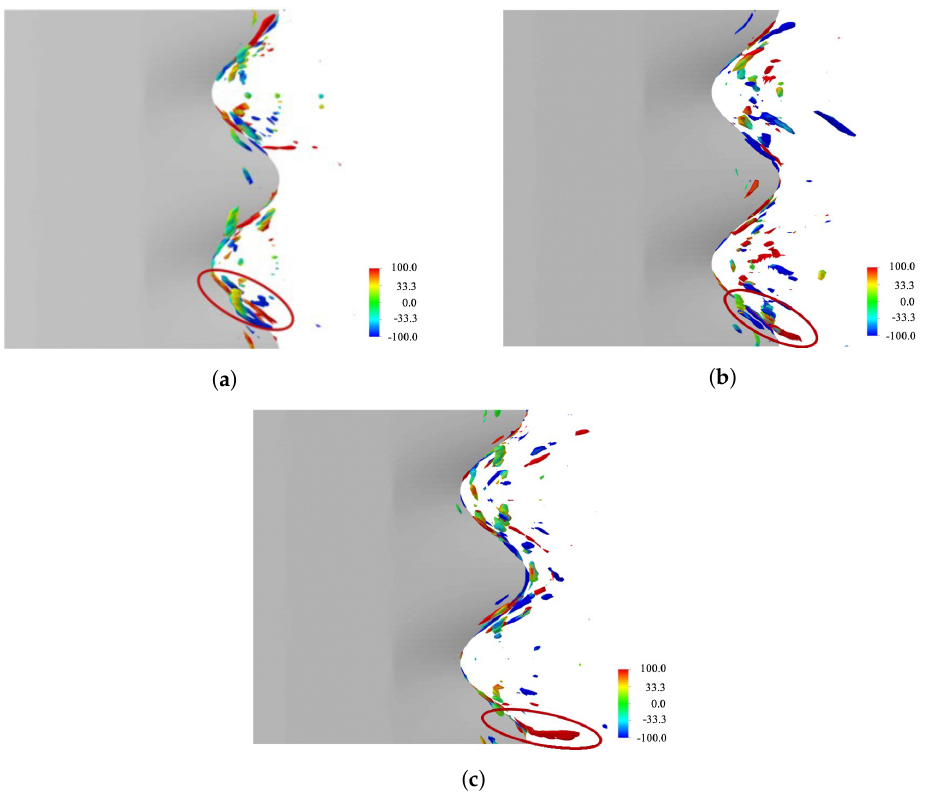
Figure 8. Time evolution of instantaneous vortex structure: Q = 2000 colored by | ω x | ≤ 100 ( T 0 means